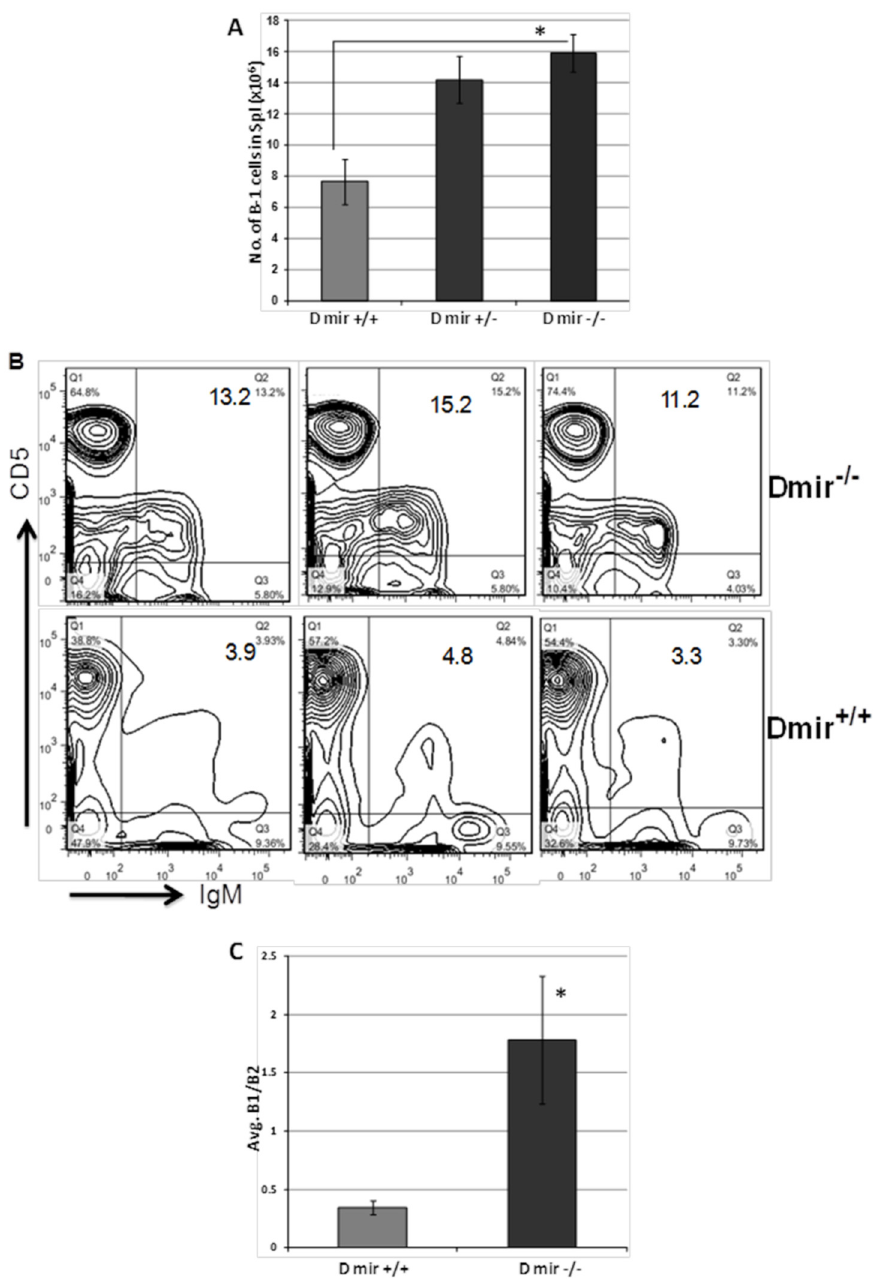
Fig 5. Effect of mir-15a/16 -1 loci on B-1 expansion. A ) Average number of total splenic B-1 cells in DBA congenic mice, * p < 0.05, One-way ANOVA with Tukey ’ s correction. B ) Representative flow cytometry data for the analysis of B cells in the spleens of DBA congenic mice which differ in the mir-15a/16-1 locus. Two genotypes of DBA congenic mice were analyzed for B cell subpopulations in the lymphoid gate (B1 = CD5+, IgM+ or B2 = CD5-.IgM+) and numbers indicate the percent of B1 cells. C ) The mean ratio of B1/B2 ± SD in congenic mice (12 – 18 mo of age), * p < 0.05, DBA mir +/+ n = 5, DBA mir -+/- n = 3, DBA miR -/- n =